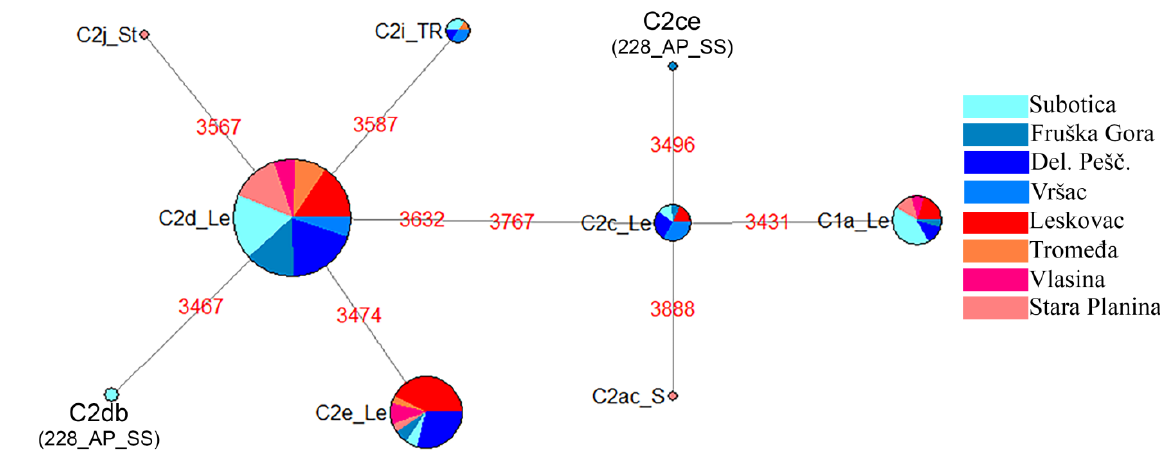
Figure 2. Median-Joining phylogeographic network of 241 mtDNA haplotypes in a Serbian A. mellifera sample based on the variability of the tRNA leu -cox2 intergenic region (motifs in red). The size of the node is proportional to the number of individuals. The origin of each sample is shown in the legend.